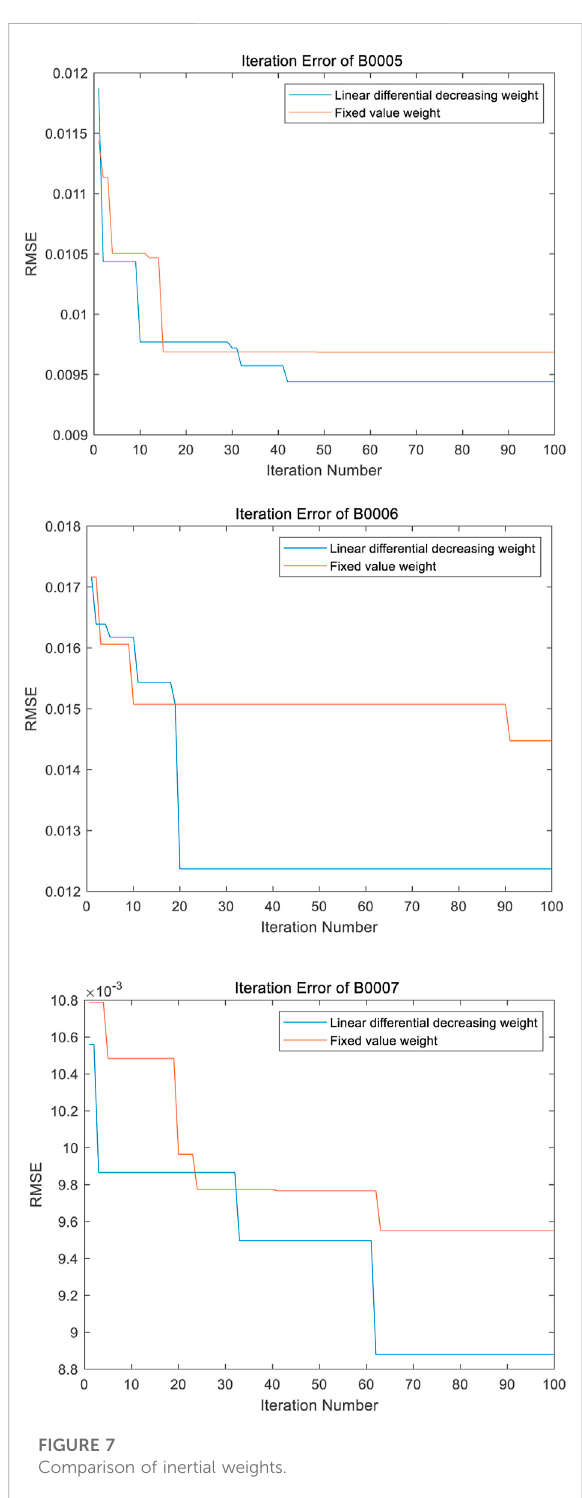
FIGURE 7 Comparison of inertial